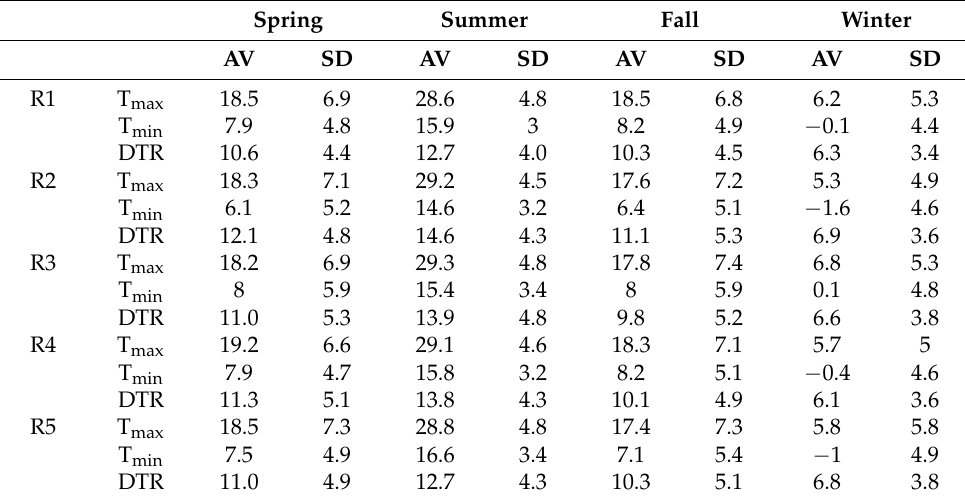
Table 4. Average and standard deviation of T max , T min, and DTR for all AWS stations under the specific